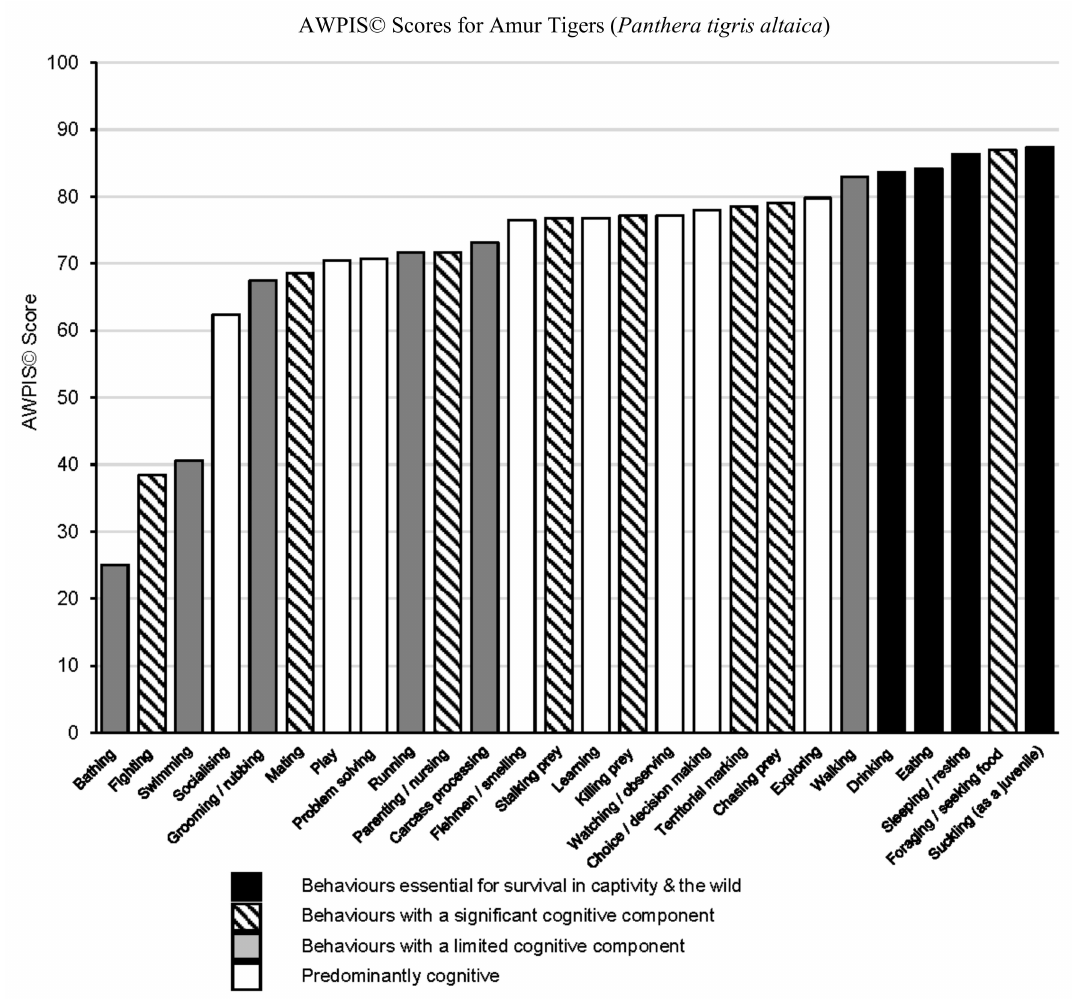
Figure 1. AWPIS © scores for Amur